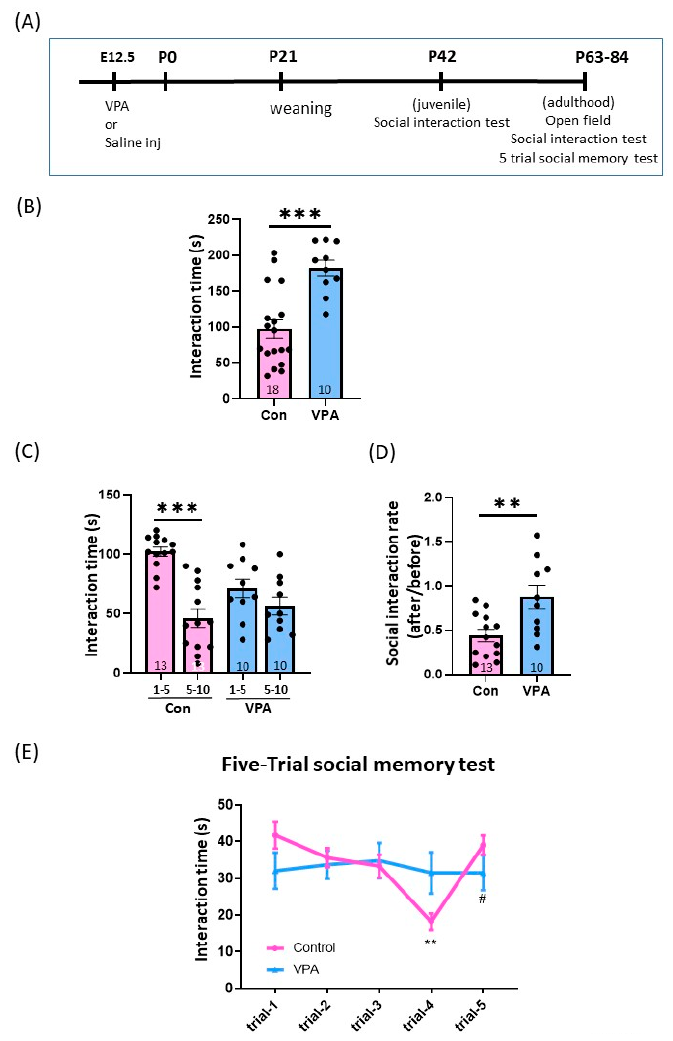
Figure 1. VPA-exposed animals show social interaction and social recognition memory deficit. ( A ) Experimental design. Pregnant dams were injected with either saline or valproic acid (VPA) on ges- tational day 12.5. The male offspring were tested in juvenile (P42) or adulthood (P63–84). ( B ) Time interacted with unfamiliar juvenile male mice during the juvenile interaction test (of in utero-ex- posed saline (control) or VPA mice (VPA). ( C , D ) Adult interaction test. ( C ) The time interacting with an unfamiliar female mouse in the first and last 5 min of the test was analyzed. ( D ) The social inter- action rate. The rate was calculated as the ratio of the interaction time with unfamiliar mice in the last 5 min to the first 5 min of the test. ( E ) Interaction time in 5-trial social memory test of control